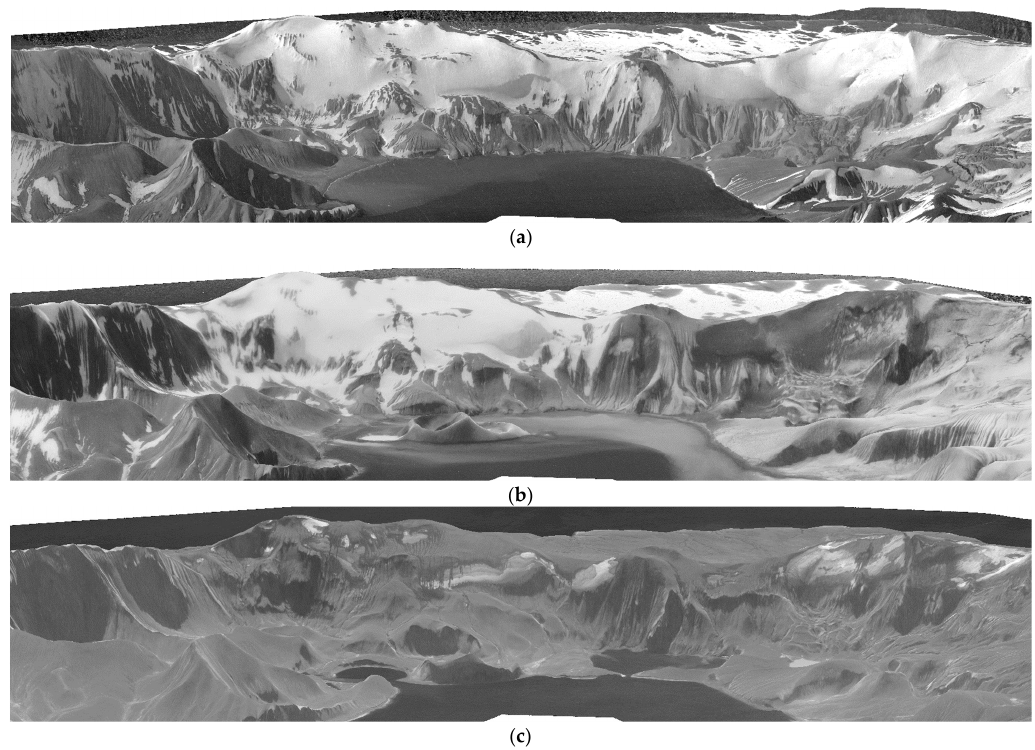
Figure A1. Telefon Bay perspective view based on 1956 ( a ), 1968 ( b ), and 2020 ( c ) orthographic mosaics and digital elevation models (height exaggeration by 3). Includes material ©KARI 2020,